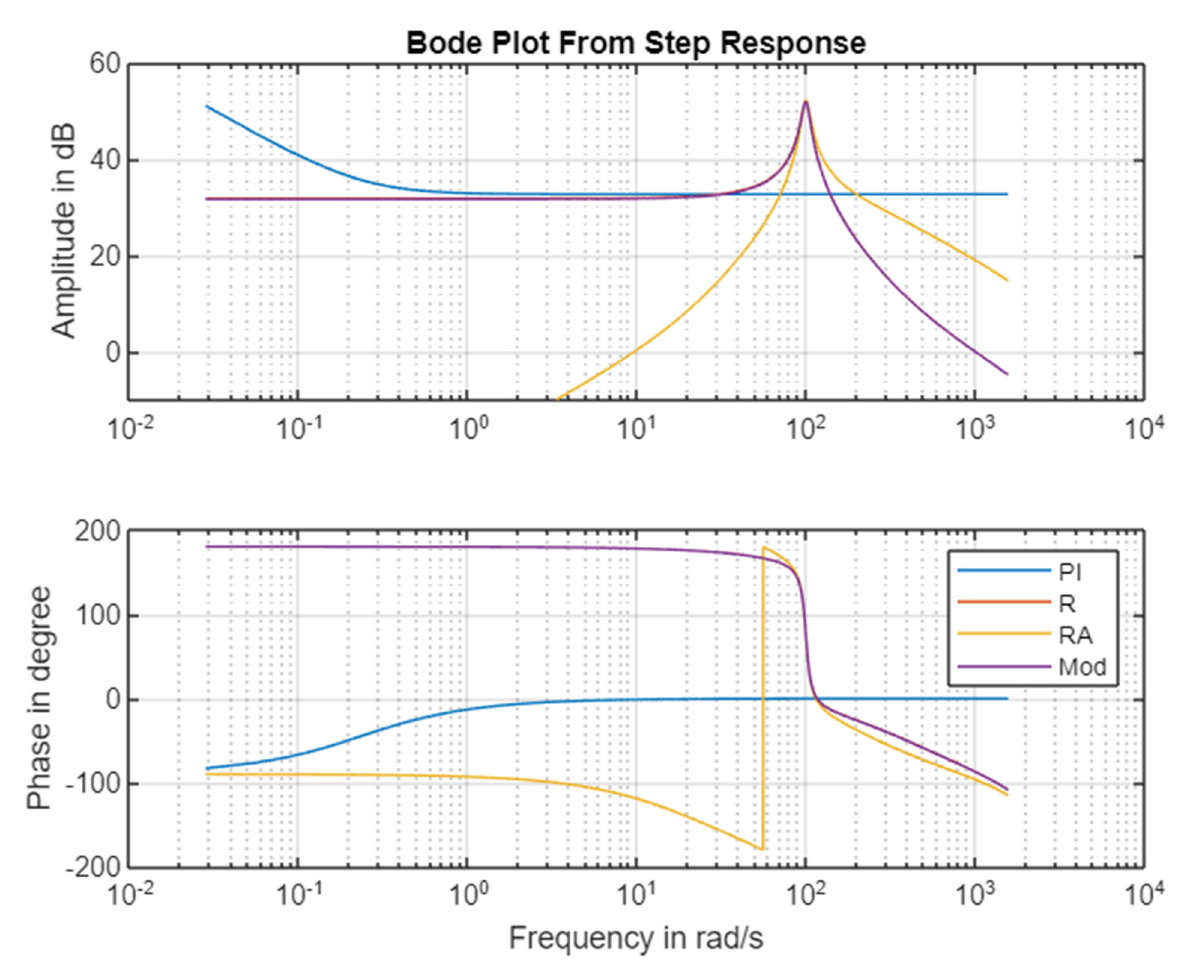
Figure 7. Bode Plot of PIR, PIRA and modulating controller.